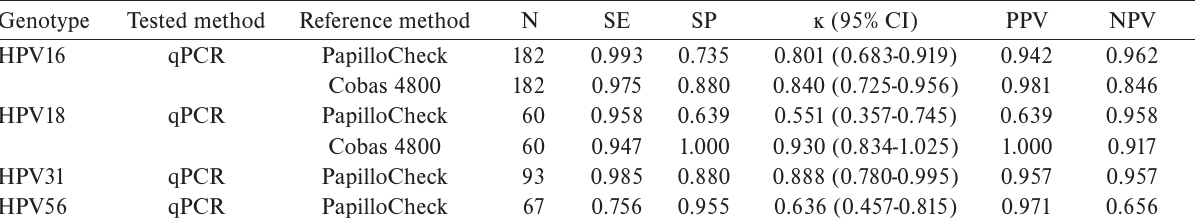
Table 4. Specificity and sensitivity of qPCR amplifications of HPV16, 18, 31, and 56 E6 genes in samples of the validation set Genotype Tested